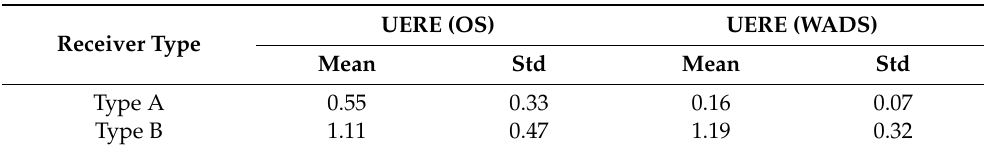
Figure 7. The UEREs and UDREs of the C04 satellite, as calculated by the type A and B receivers for the B1I/B3I IF combination in the WADS. Table 4. The results of the BDS satellite UEREs, as calculated by type A and type B receivers under the OS and the WADS (unit: